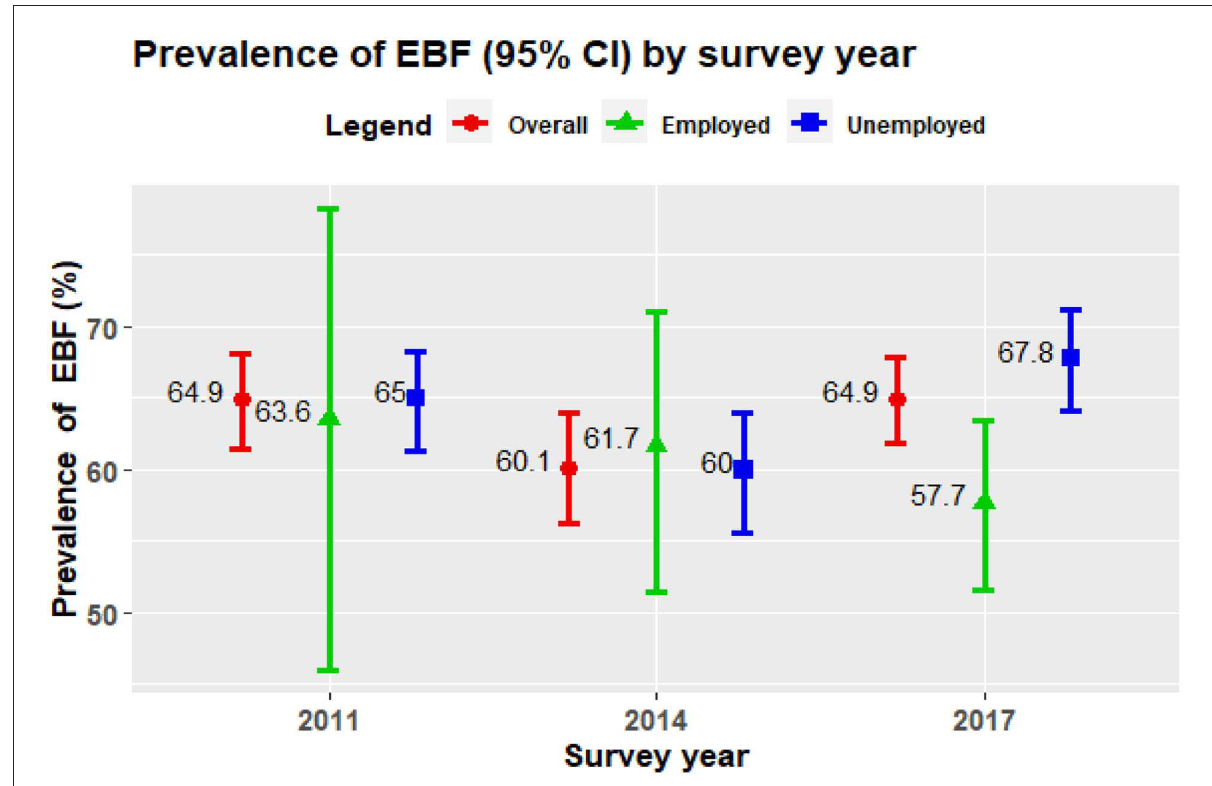
FIGURE1 Prevalence of exclusive breastfeeding (EBF) practice (95% confidence interval) among employed and unemployed women in Bangladesh.